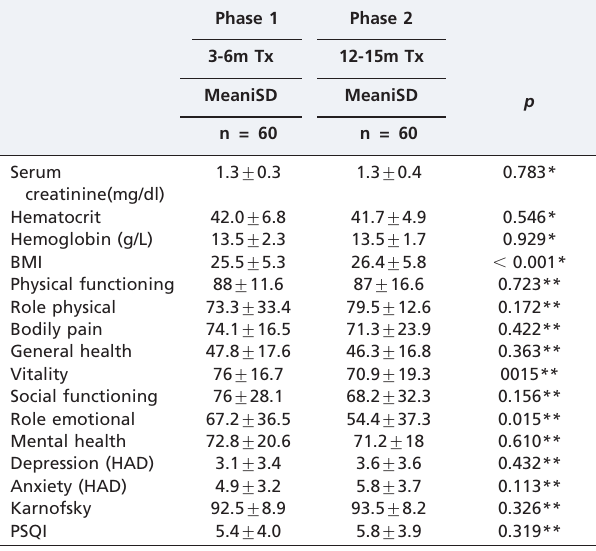
(*) paired t test; (**) Wilcoxon non-parametric testBMI, body mass index; HAD, hospital anxiety and depression; PSQI, Pittsburgh sleep quality index; SF36